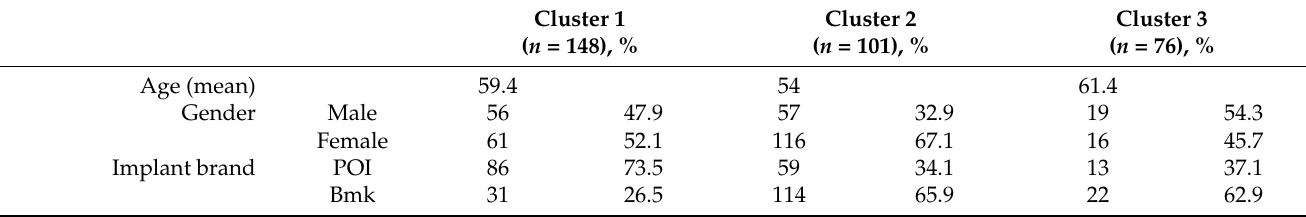
Table 5. Features among three clusters at implant